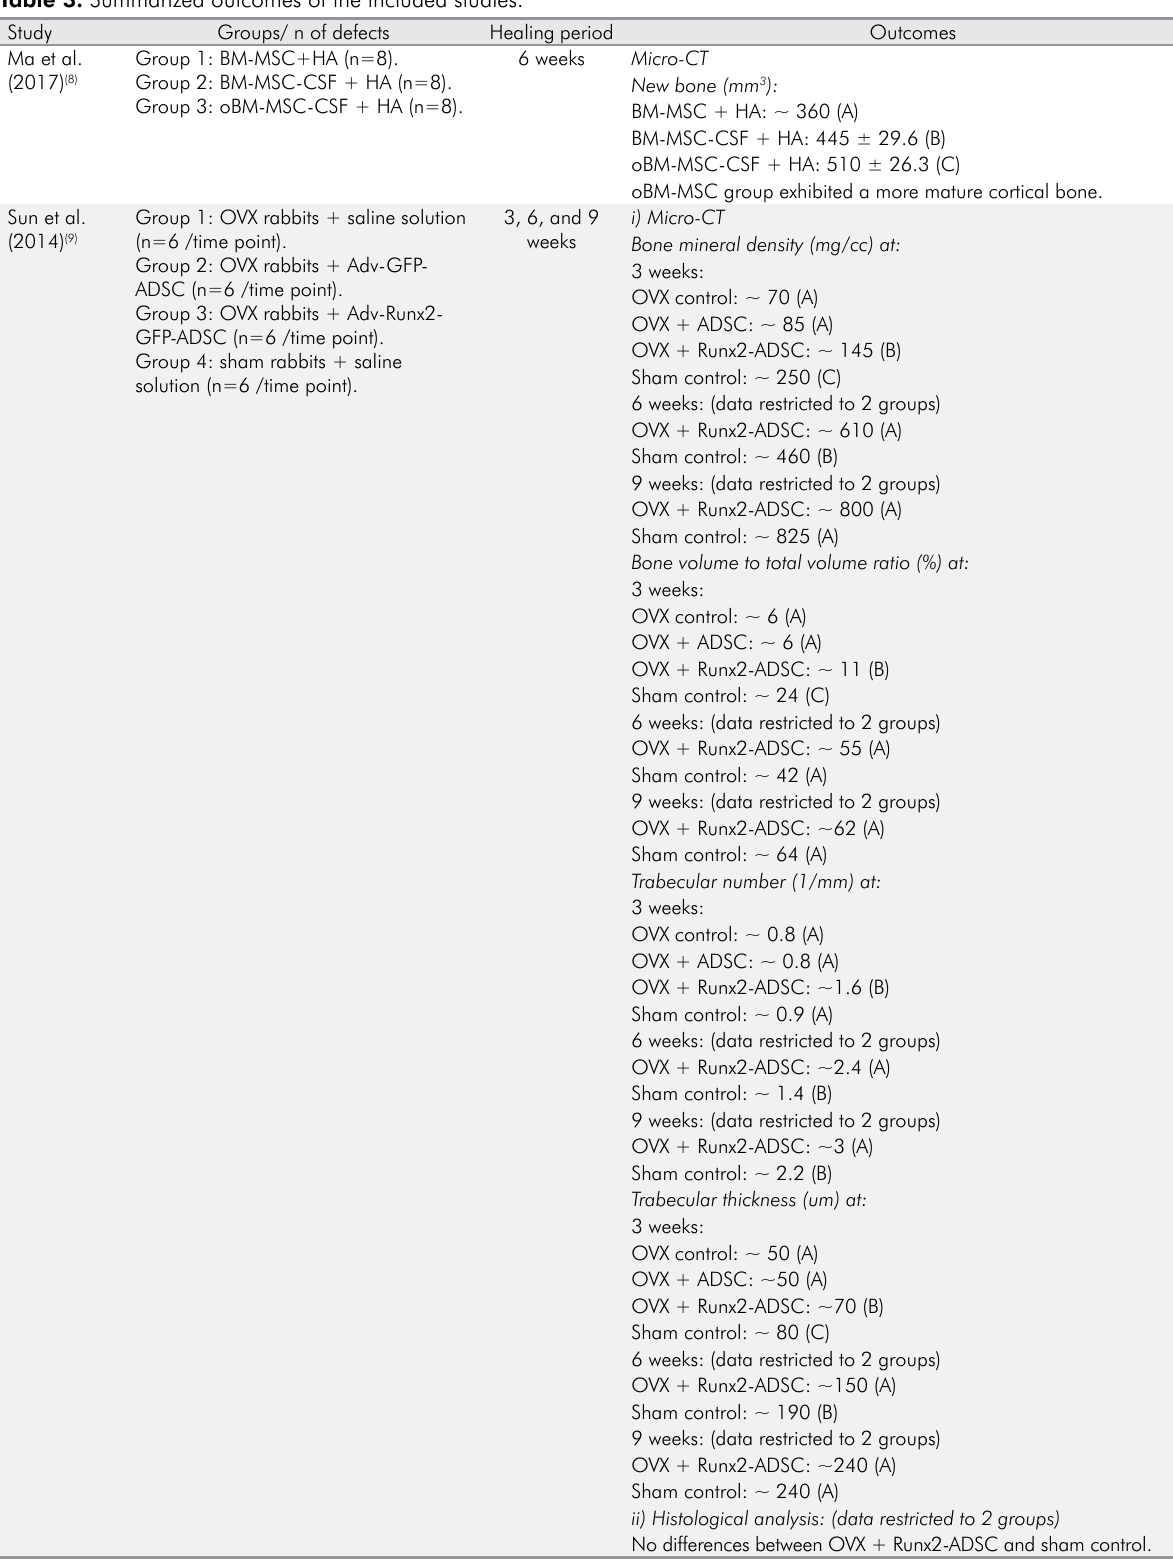
Table 3. Summarized outcomes of the included